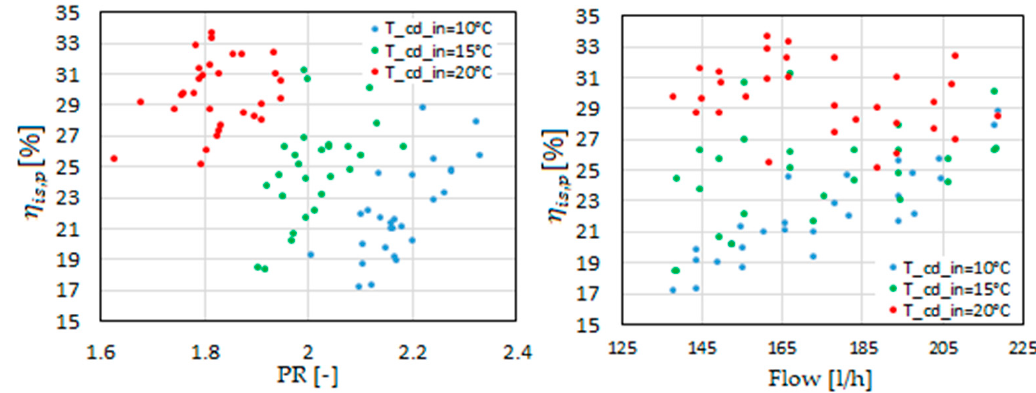
Figure 4. The refrigerant pump isentropic efficiency with pressure ratio (PR) ( left ), and with flow rate ( right ). Instead, the pump volumetric efficiency shows high values as presented in Figure